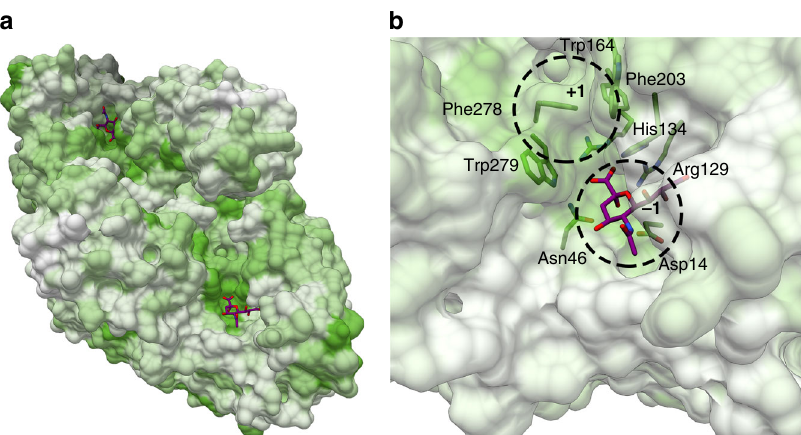
Fig. 3 EnvSia156 homology and binding subsites. a Birdseye view of an EnvSia156 dimer with the van der Waals ’ surface colored according to sequence conservation, calculated by aligning sequences (ClustalOmega) with the closest primary structure homologs found in GenBank using the BLASTP tool. The color pattern matches the alignment used to render the structure (Supplementary Fig. 3), with darker shades of green corresponding to full conservation and white to no conservation. b Detailed view of the catalytic site of EnvSia156 with putative substrate coordinating residues in a stick representation, colored according to sequence conservation. The − 1 and putative + 1 binding sub-sites are highlighted with dashed